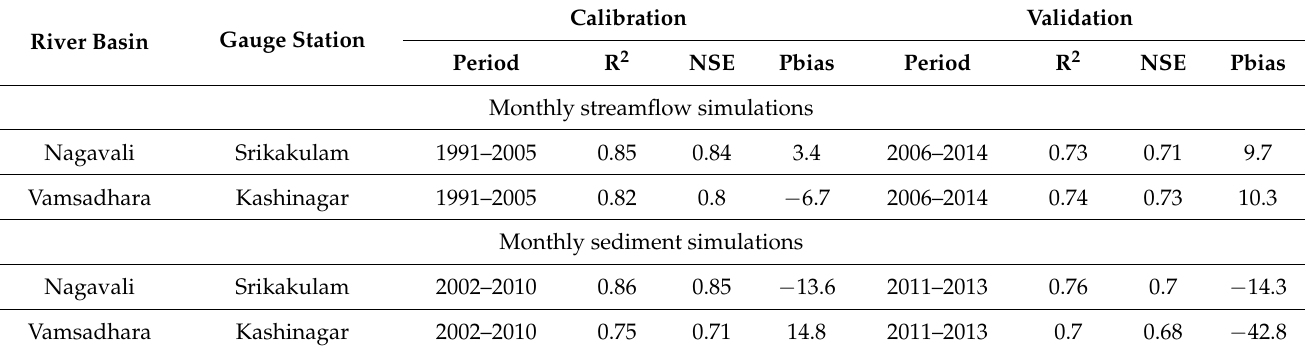
Table 5. Calibration and validation